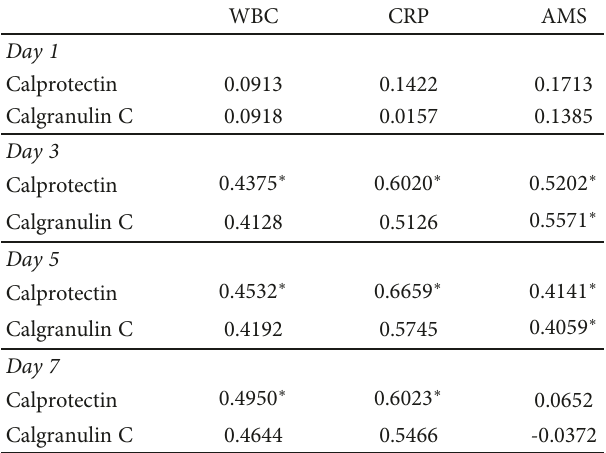
Table 5: Correlations of calprotectin and calgranulin C serum levels with the CRP levels, WBC counts, and AMS levels in the pancreatic drainage fl